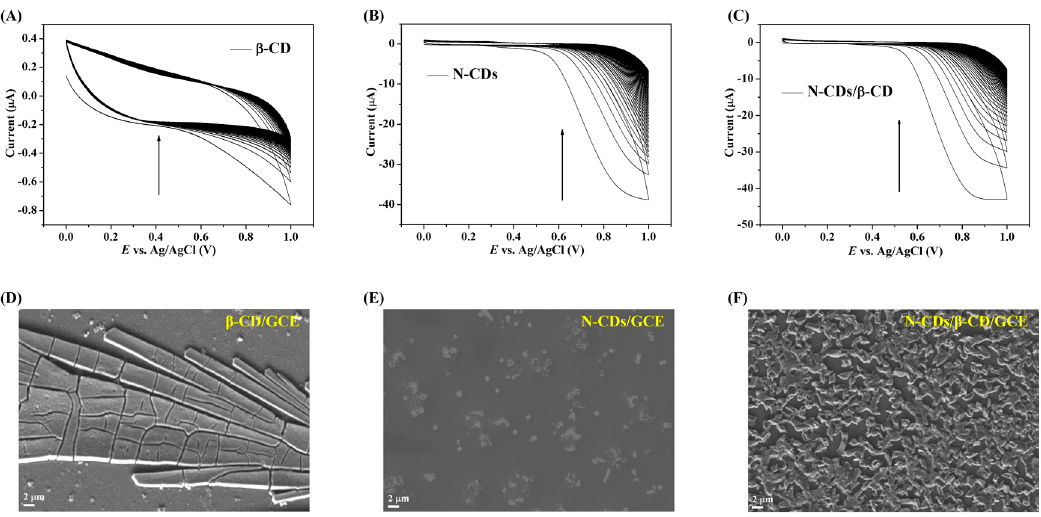
Figure 3. CVs of β -CD ( A ); N-CDs ( B ) and N-CDs/ β -CD nanocomposites ( C ) at GCE surface; Scan rate: 100 mV · s − 1 ; scan potential: 0 to 1.0 V; consecutive cycles: 50; SEM images of β -CD/GCE ( D ); N-CDs/GCE ( E ) and N-CDs/ β -CD/GCE ( F ). N-CDs/ β -CD/GCE was further verified by a microscopy technique. The SEM images of